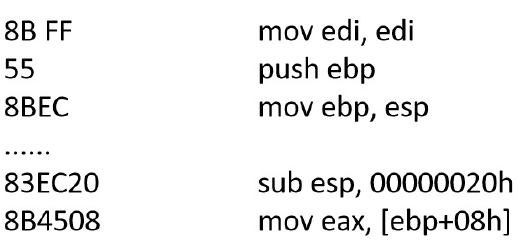
Figure 4. A sample of a feature byte sequence.